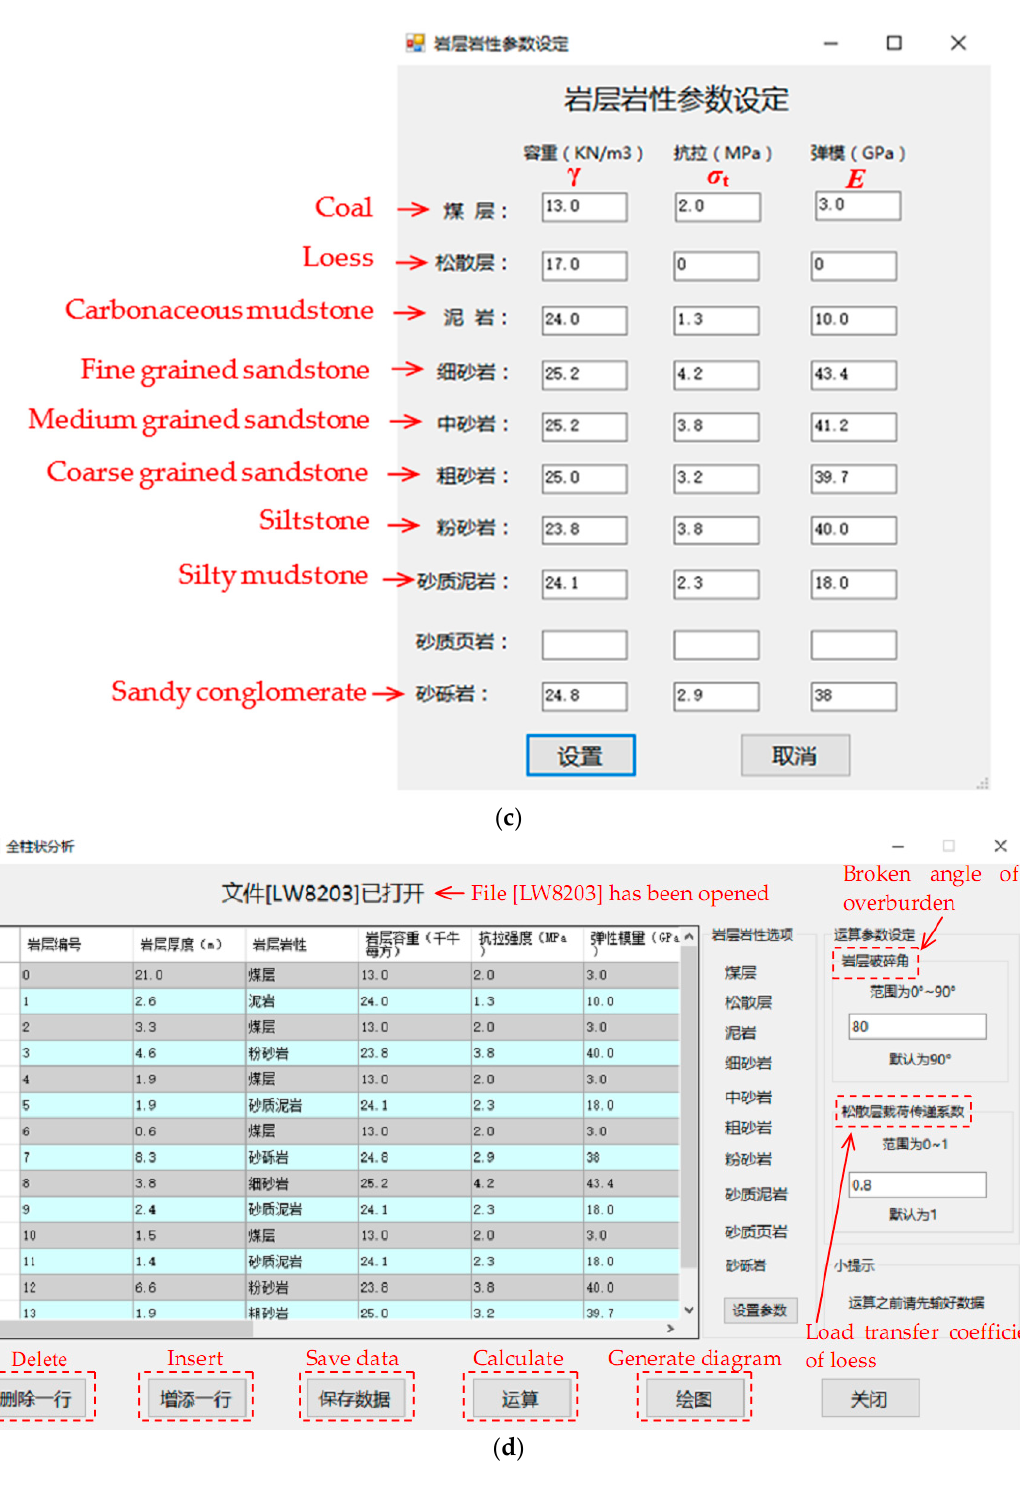
Figure 3. The workflow to determine the KS of LW8203 (Chinese version). ( a ) Software interface; ( b ) Creating a file; ( c ) Entering the properties of the overlying rock material; ( d ) Calculating and generating the diagram.